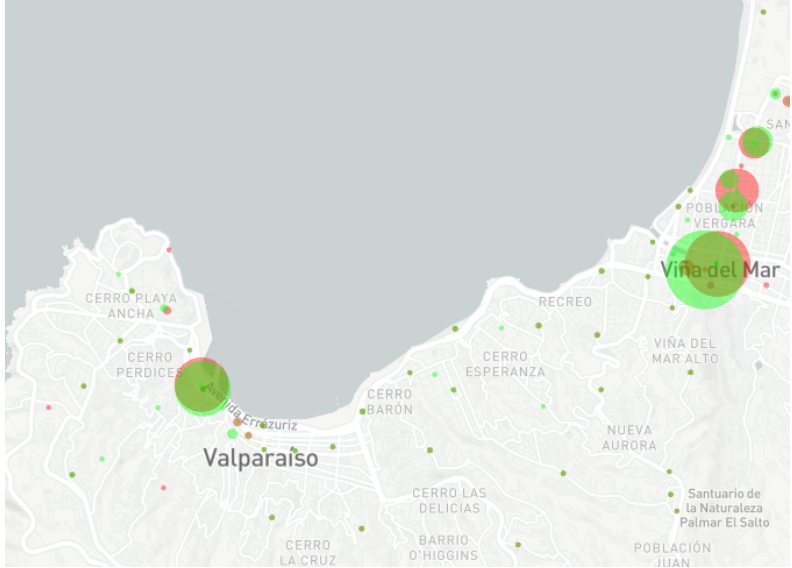
Figure 1. Visualization of sites in the Valparaíso area in a time period of 15 min. Some sites receive neighboring network hits (NNHs) (red), and others lose network hits (NHs) (green). Most of them are in sectors whose geography allows a clean line-of-sight between